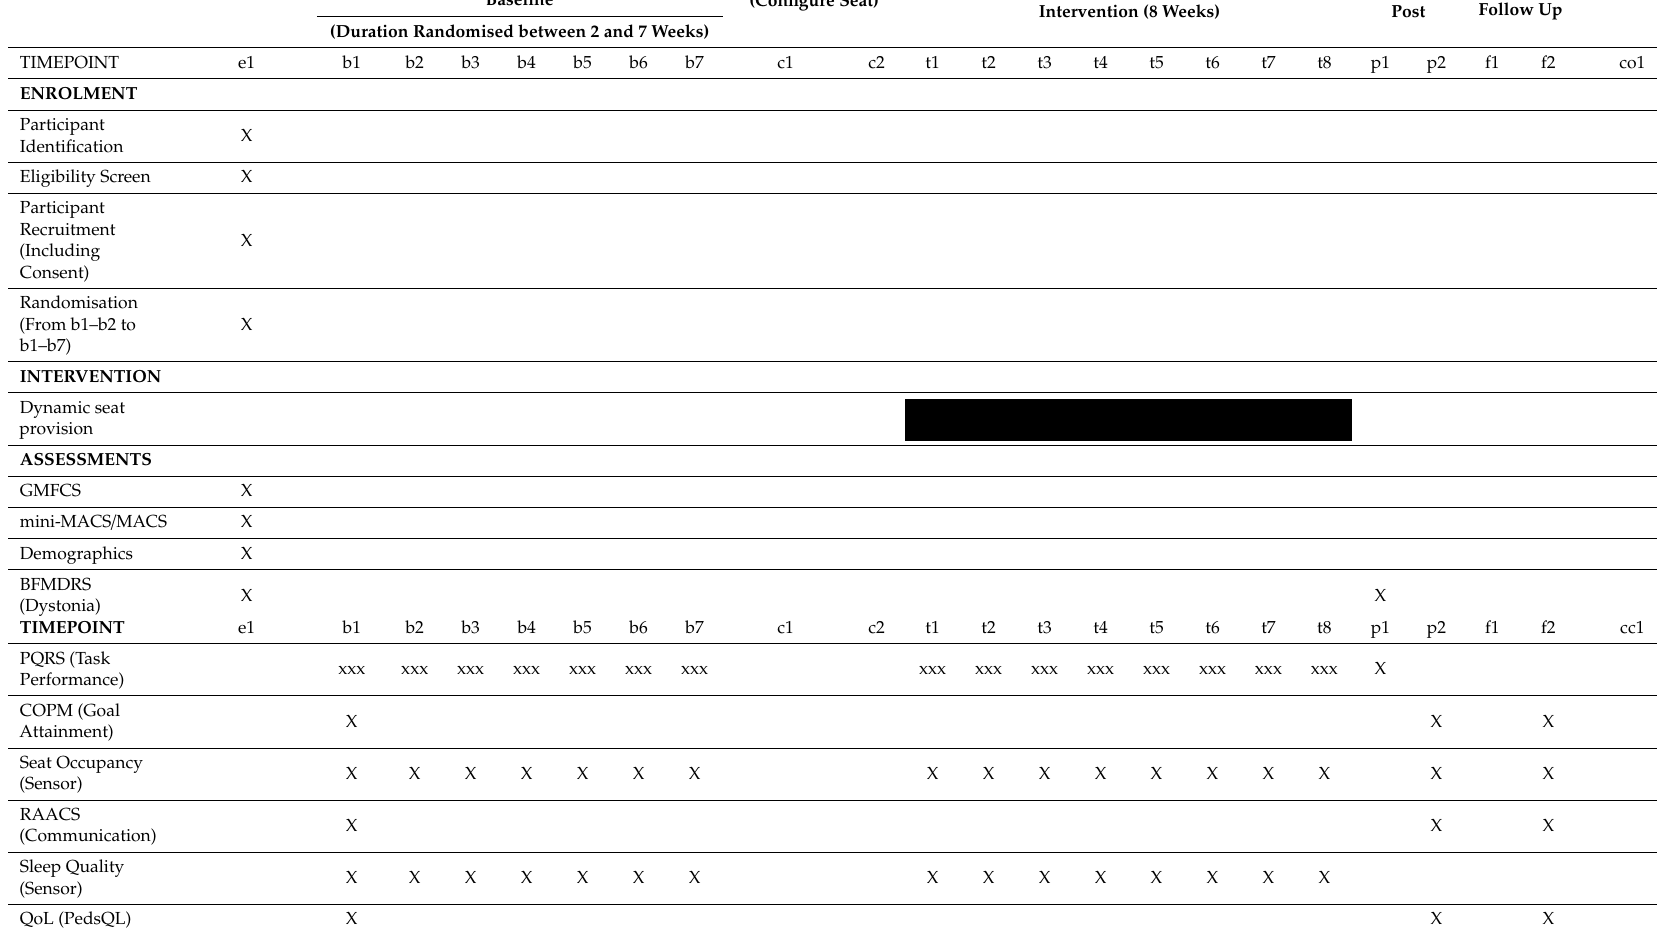
Close Out Baseline